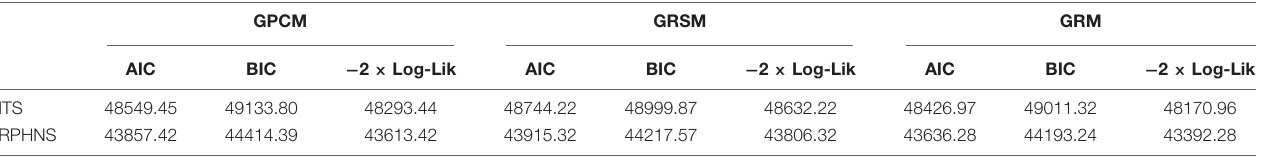
TABLE 3 | Psychometric characteristics of the scales within the IRT framework.